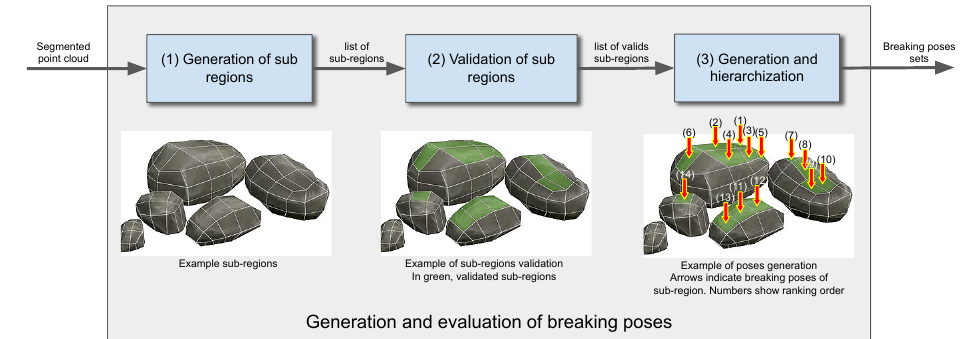
Figure 5. Block diagram of the target pose generation and evaluation